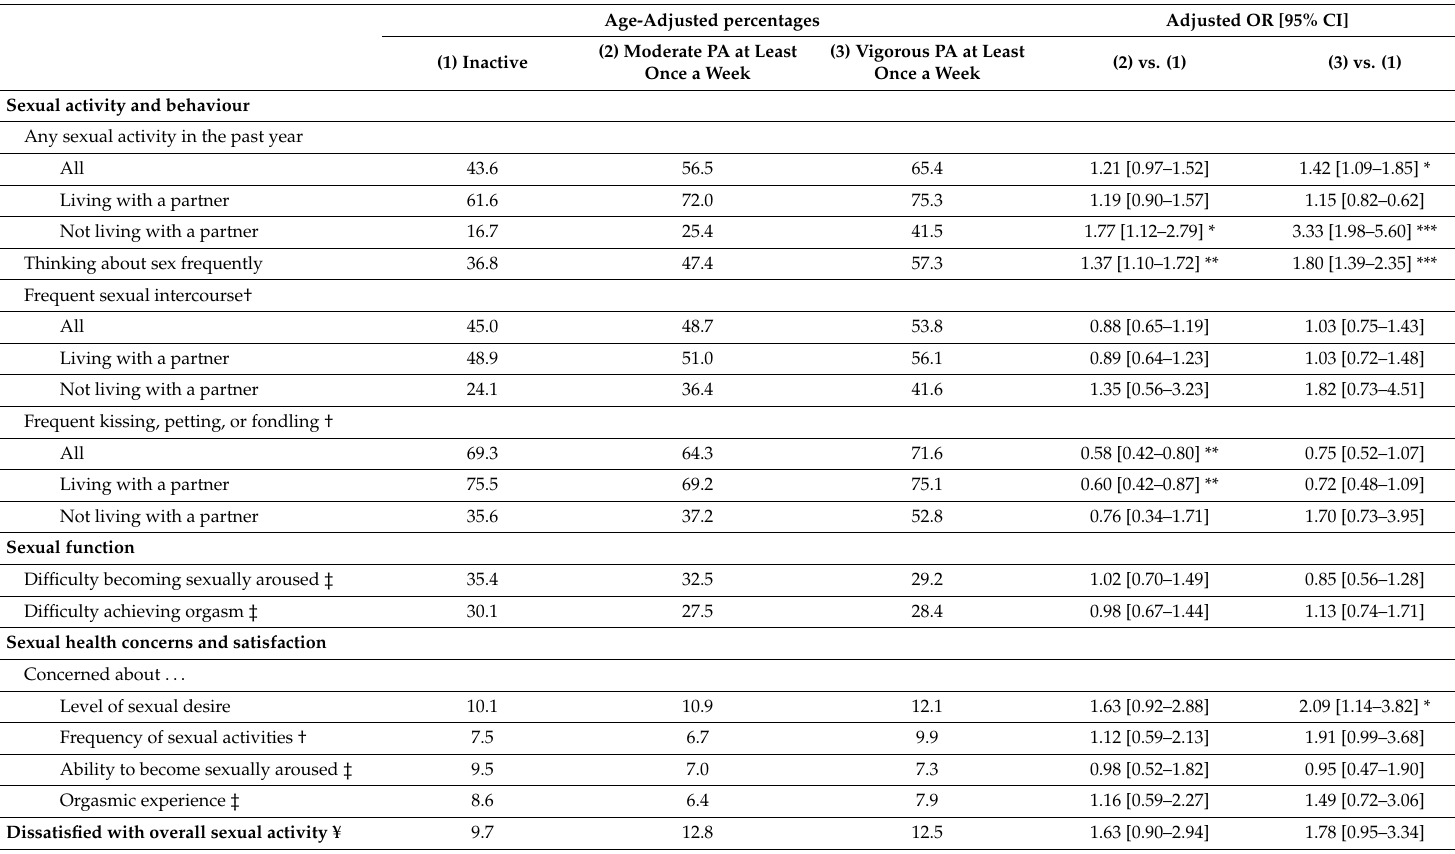
Table 3. Sexual activities, functioning and concerns in relation to physical